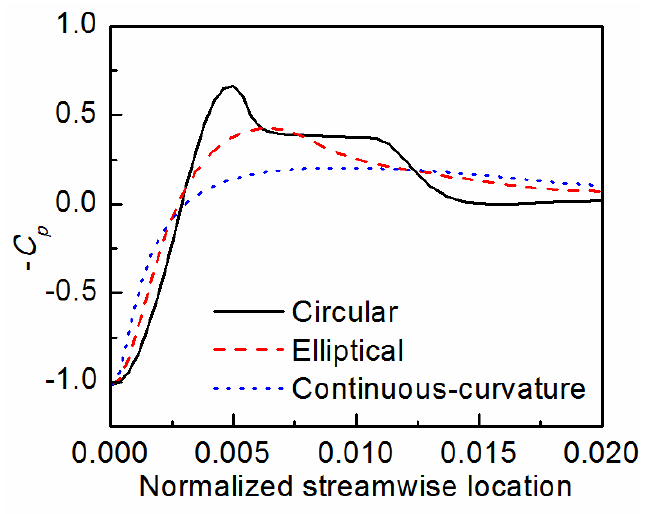
Figure 11. Pressure distributions at α =